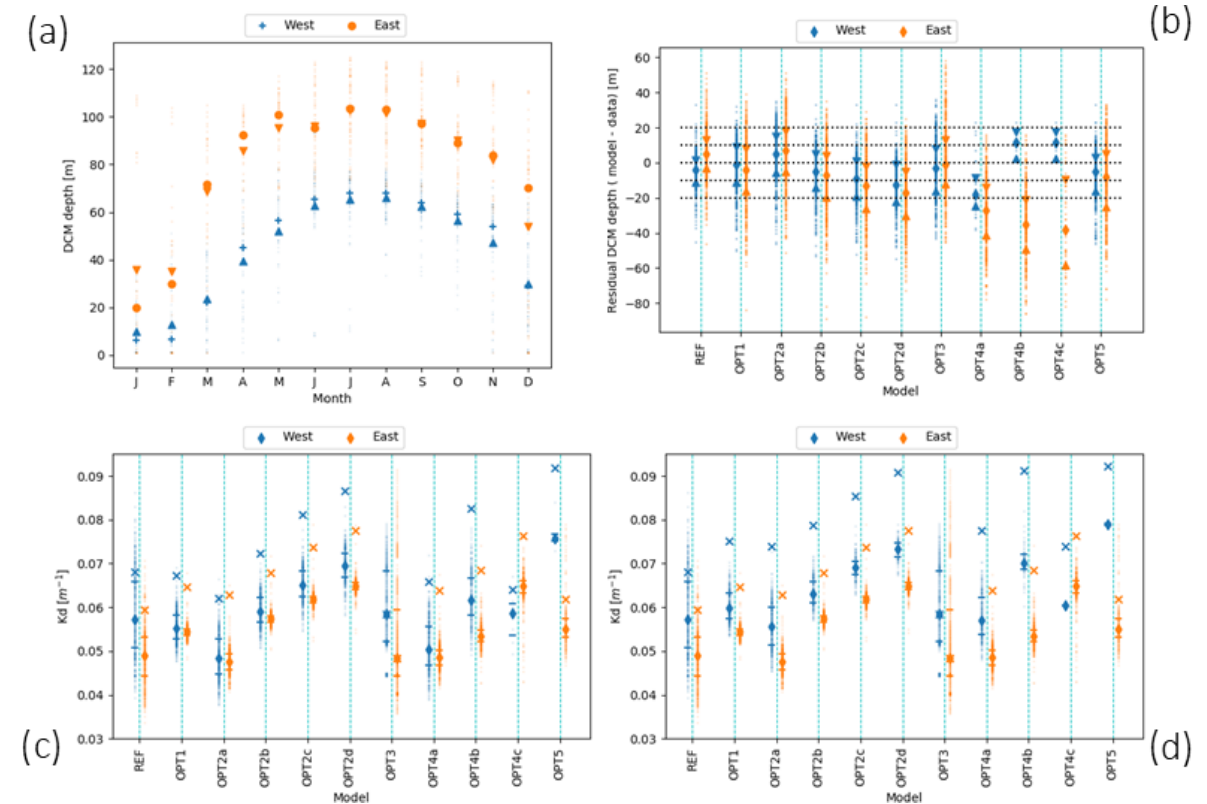
Figure 9. (a) Monthly average of DCM depth for west (blue) and east (orange) profiles derived from REF simulation. Circles and crosses are the mean; triangles are medians. (b) Scatter plots of the residual difference between measured and modelled DCM. The x axis reports model configurations listed in Table 1. On the y axis, residuals’ median values for west (blue) and east (orange) profiles are shown. Triangles indicate the 25th and 75th percentiles. (c) K d for west and east subbasins during the stratified period; diamonds indicate the median over the vertical column; 25th and 75th percentiles are the horizontal lines. Crosses show the maximum over the vertical column. Panel (d) is the same as (c) but with double initial nutrient concentrations for the western basin simulations.